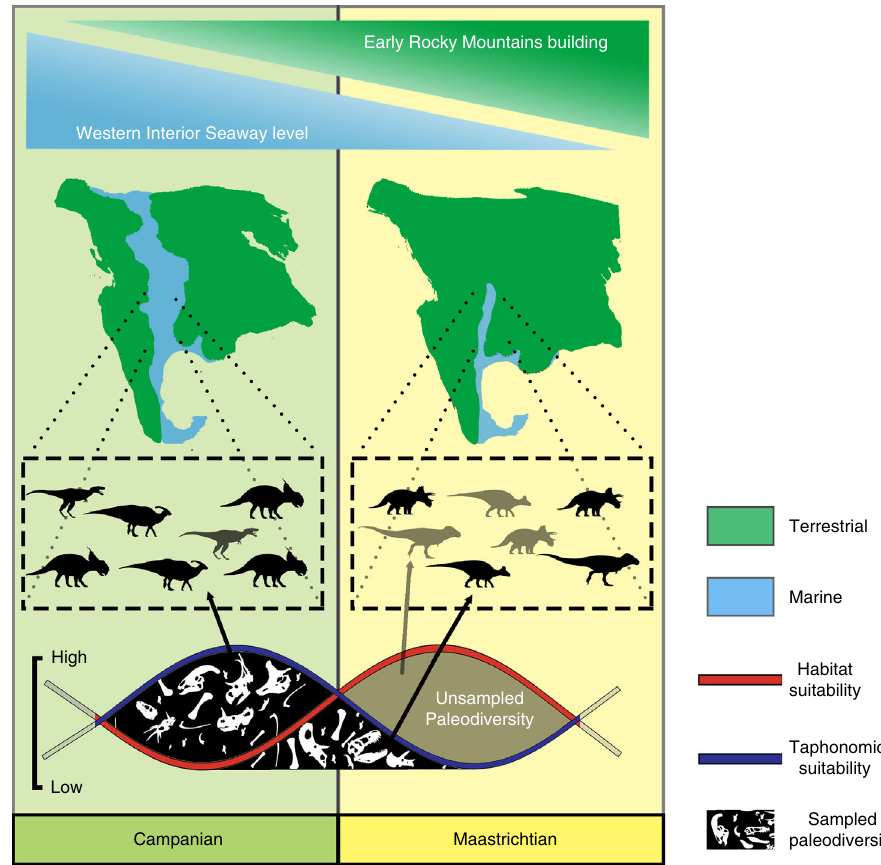
Fig. 6 Conceptual integration of the results from niche modelling and geological modelling of fossil occurrences. Eustatic (blue shaded bar on top) and tectonic (top green shaded bar) drive the distribution of depositional environment affecting fossil preservation. Campanian palaeogeography (left) fosters increased and more widespread preservation of fossil communities than the Maastrichtian (right) due to the higher accommodation space provided by the highstand of the Western Interior Seaway (left) than during the late Maastrichtian regressive phase (right). On the other hand, the latter time interval (right) may have provided equal if not greater habitable space in terrestrial areas, which are not captured by the geologic record. Diagram at the bottom shows how a high Maastrichtian habitat suitability (red line) is not in phase with the lower preservation potential of this stage, causing lower taphonomic suitability than in the Campanian. This combination of conditions provide a depauperate raw diversity record for non-avian dinosaurs towards the K/Pg. Chasmosaurinae silhouette by Mariana Ruiz (modi fi ed by T. Michael Keesey) under the Public Domain Mark 1.0. Saurolophinae silhouette by